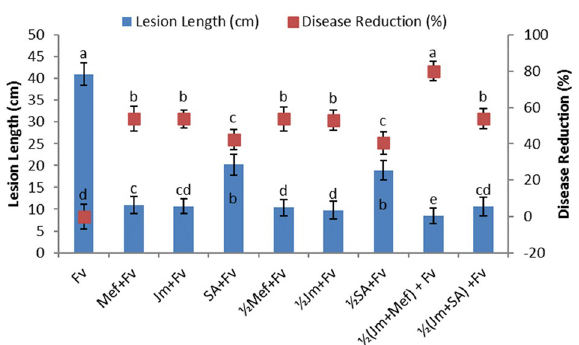
Figure 1. Effect of seed treatments with J. mimosifolia extract and control formulations on stem lesion length and disease reduction in maize inoculated with F. verticillioides (21 days after inoculation) in pot experiments under controlled conditions. Data are expressed as mean ± standard deviation (SD) of three replicates. Mean values with different letters are significantly different from each other according to the least significant difference ( LSD ) test at P < 0.05. See Table 1 for